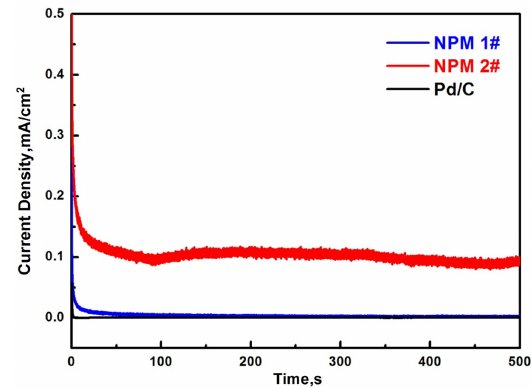
Figure 5. Chronamperometic current density-time curves in 0.5 M H SO +0.5 M HCOOH 2 4